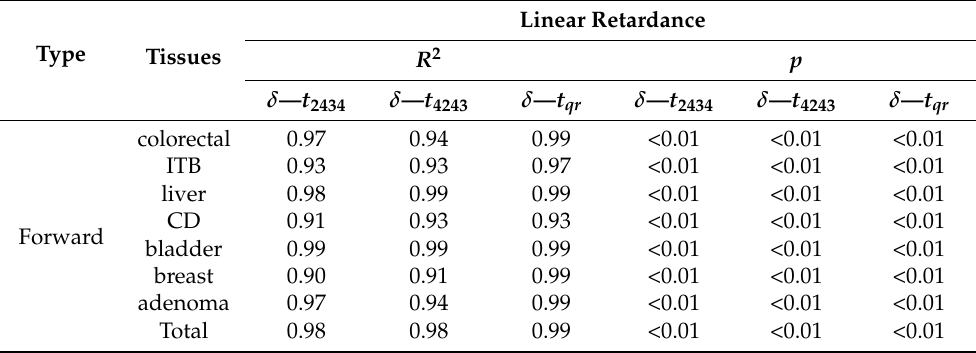
Table 4. Correlation and statistical analysis comparison results between forward measured MMT and MMPD linear retardance parameters for each kind of thin tissue